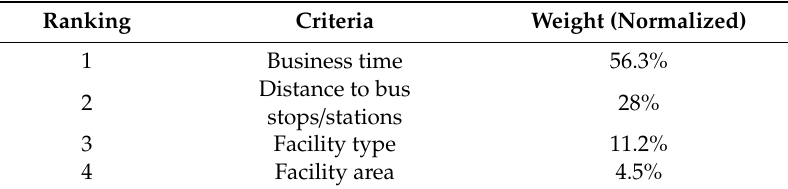
Table 5. Weight of criteria.